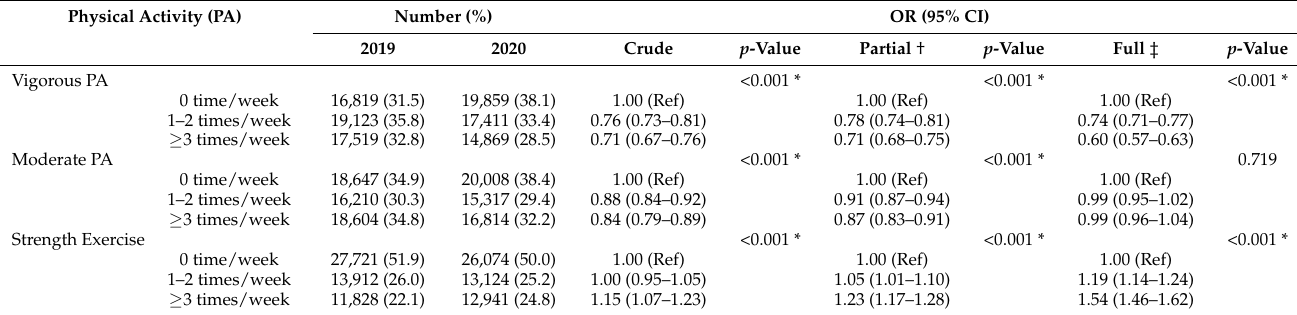
Table 3. Odd ratios of exercise pattern in 2020 compared to 2019 in total